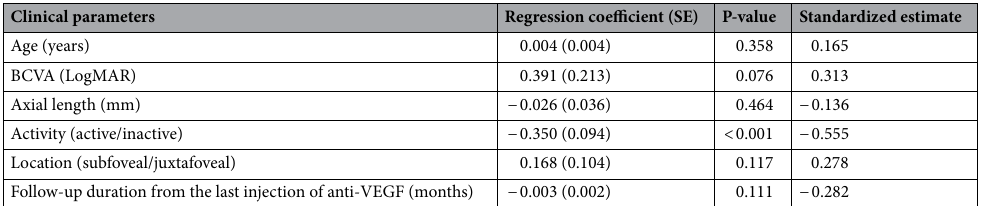
Table 2. Univariate regression analyses of the median size of flow signal areas and other factors in optical coherence angiography of myopic choroidal neovascularization. SE standard error, OCTA optical coherence tomographic angiography, BCVA best-corrected visual acuity, VEGF vascular endothelial growth factor, LogMAR logarithm of the minimum angle of resolution.